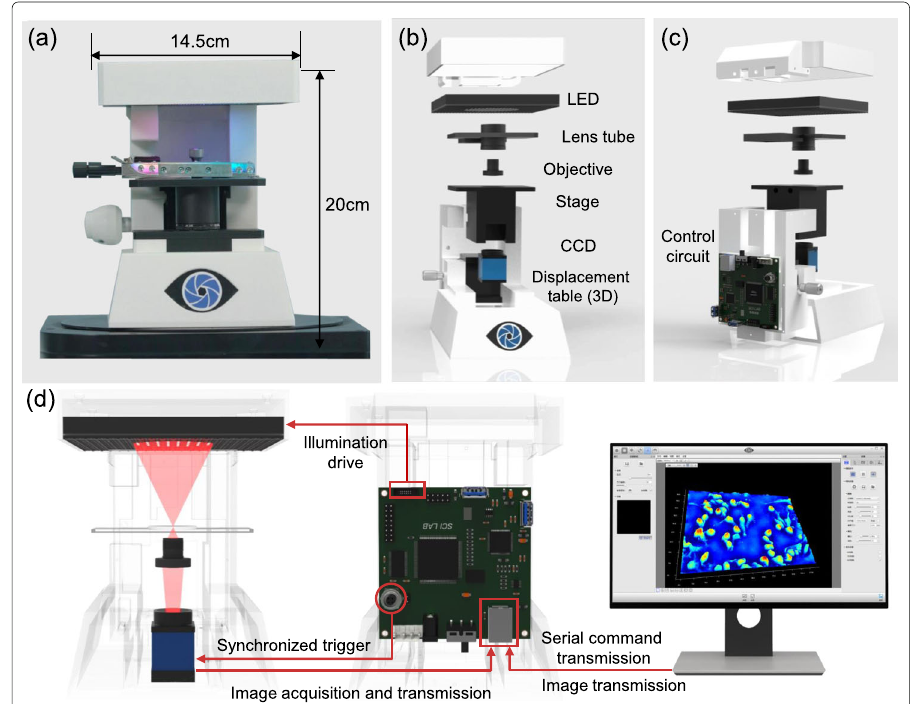
Fig. 19 Schematic diagram of MMC-SCLM. (a) Physical diagram of MMC-SCLM. (b), (c) Internal structure diagrams from different angles. (d) Hardware system interactive control